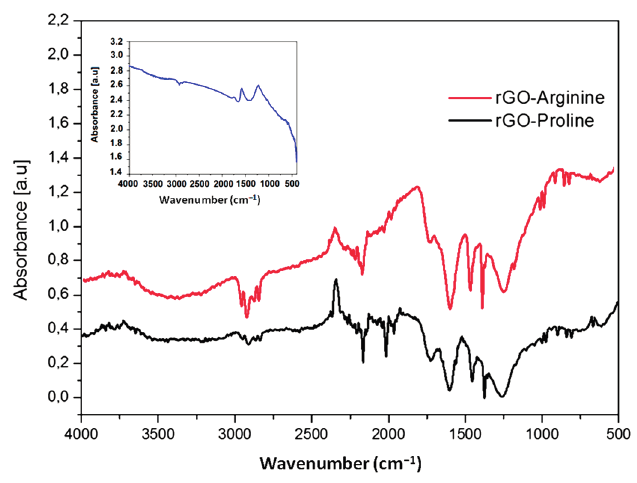
Figure 2. Fourier transform infrared spectroscopy spectra of reduced graphene oxide (top left) and reduced graphene oxide with arginine and with proline.